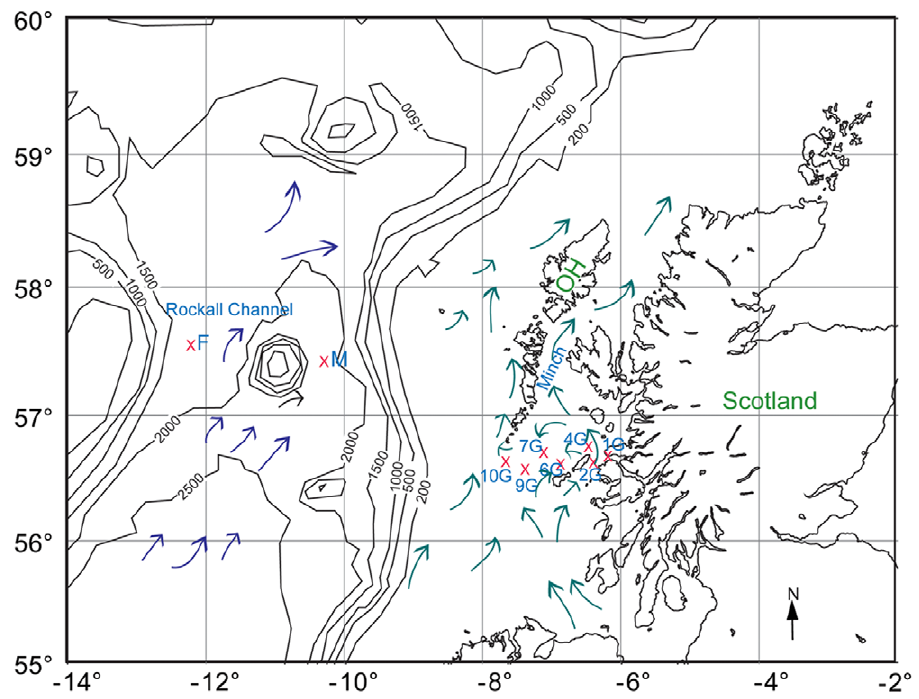
Figure 1. Cruise sampling stations. Ellet Line stations include shelf stations 1G–10G and open Atlantic Ocean stations M and F. Lines represent bathymetry and arrows represent circulation patterns of the Scottish coastal current and the North Atlantic surface water, redrawn after Ellett [51] and McKay et al. [50]. OH is the Outer Hebrides, the island chain lying to the west of the Minch.